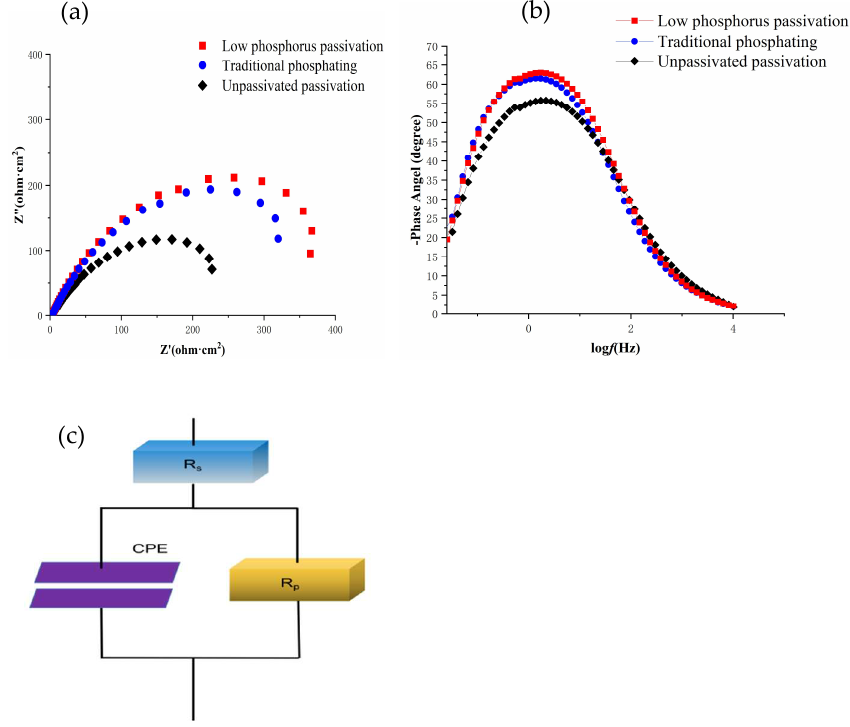
Figure 3. ( a ) Electrochemical impedance spectroscopy of passive film formed by Q235 steel by differ- ent treatment methods in 3.5% NaCl solution; ( b ) phase angle vs. frequency; ( c ) EIS equivalent circuit. Table 5. EIS parameters fitted by the equivalent circuit proposed in Figure 3c .